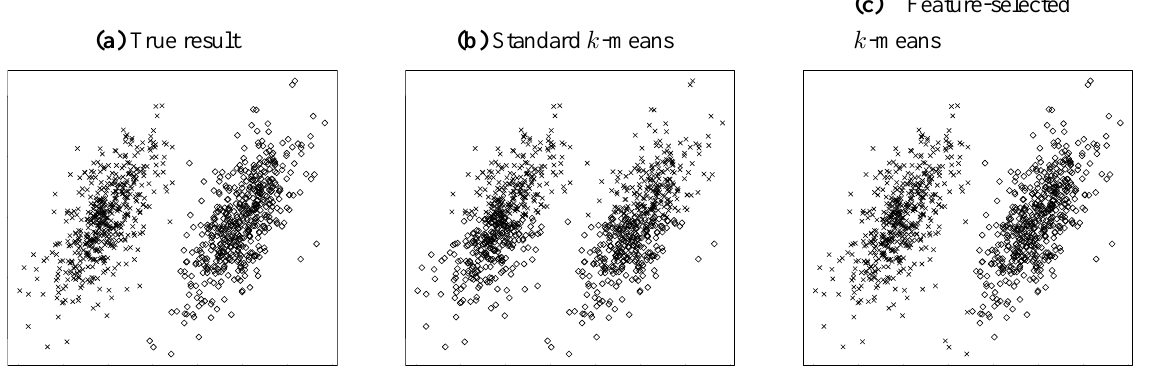
Figure 2. The effect of feature selection, where the only difference between the two clusters lies in the fluctuation of their horizontal